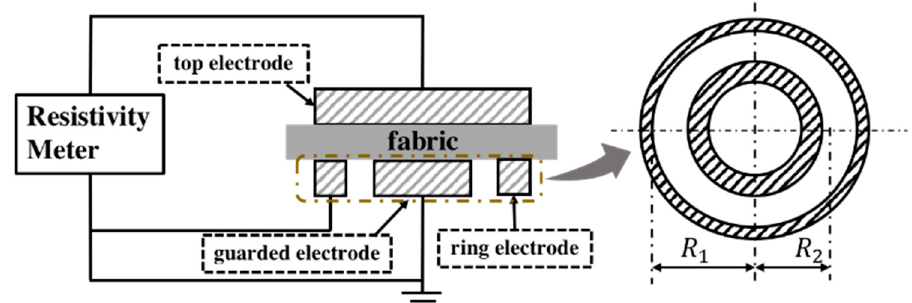
Figure 1. Measurement of electrical resistance for Cu/Ni-coated Milife fabric.